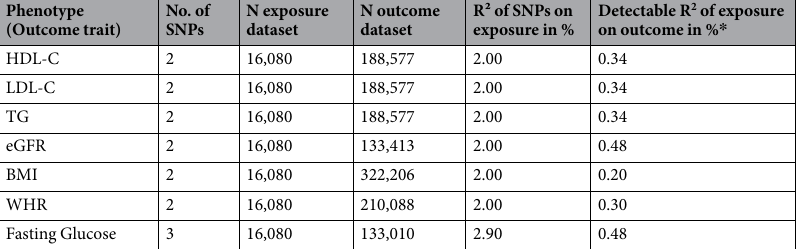
Table 2. Strength of instrumental variables used for the MR analyses: Explained variance (R²) of SNPs on apoA-IV as exposure trait and detectable causal explained variance (R 2 ) of apoA-IV as exposure trait on